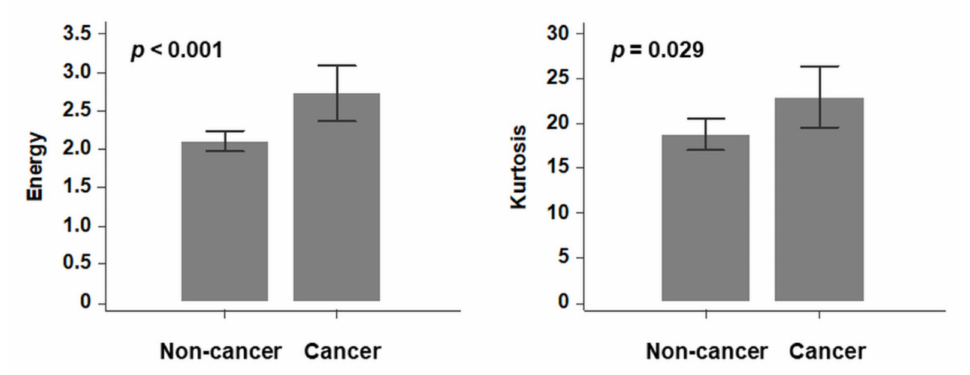
Figure 3. Radiomics features (energy and kurtosis) with significant differences between cancer and non-cancer groups.